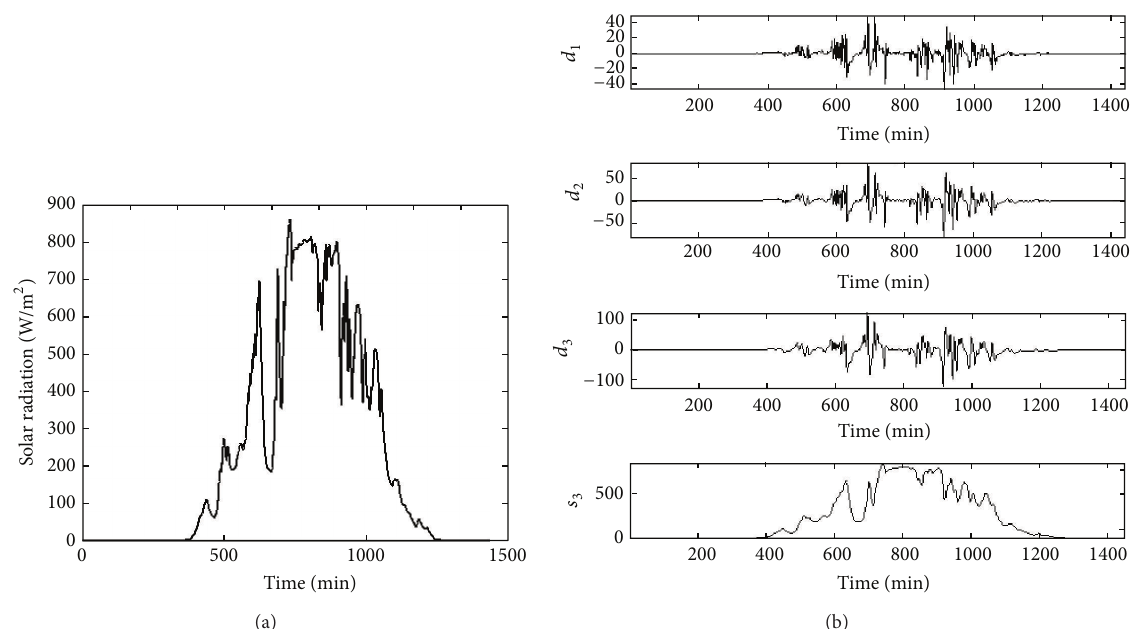
Figure 6: In (a), the solar radiation pattern used as test and, at (b), his decomposition using a filter bank. The signals 𝑑 1 , 𝑑 2 , and 𝑑 3 are obtained by high-pass filtering of the original one and 𝑠 3 from low-pass filtering.